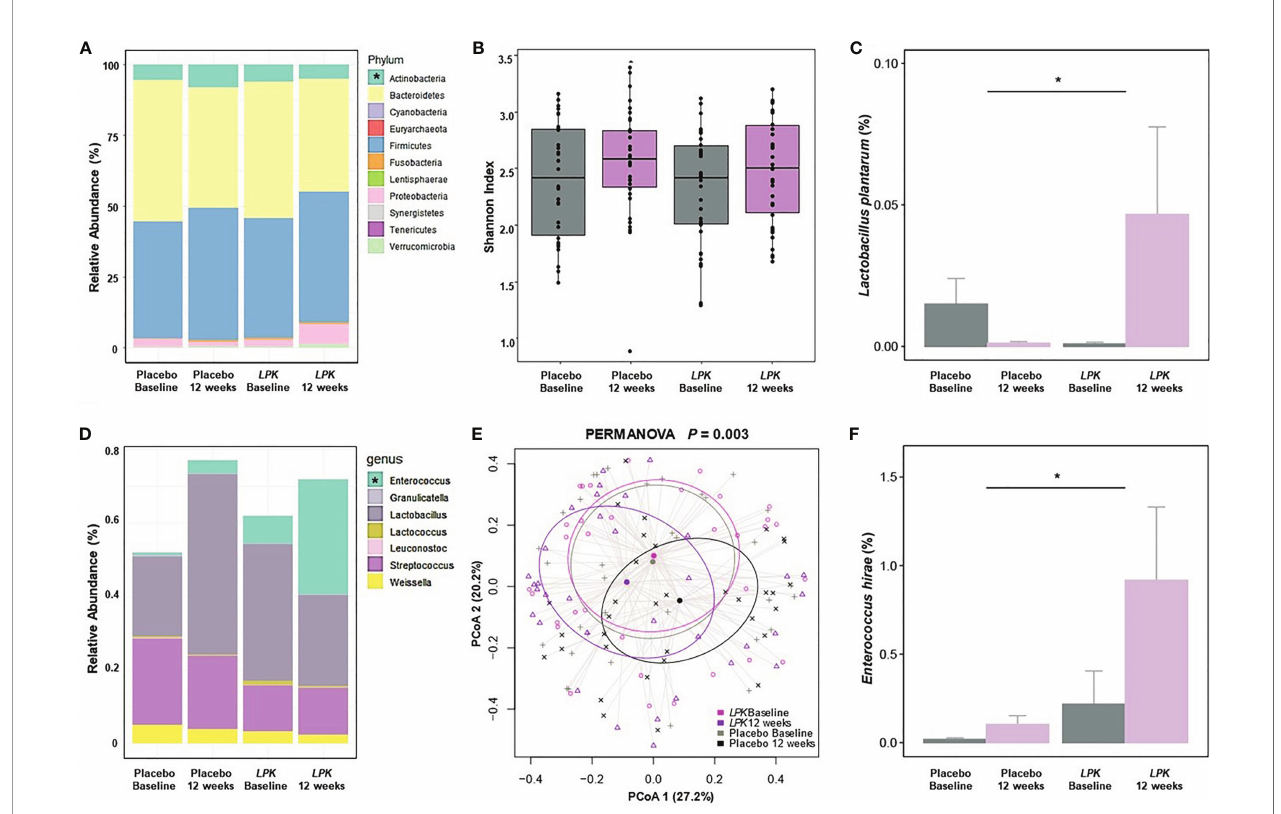
FIGURE 2 | Changes in gut microbiota after a 12-week dietary supplementation with LPK or placebo. (A) Relative abundance of the phyla. (B) The alpha diversity is shown as a Shannon index. (C, F) Comparison of logarithmic mean changes of rare fi ed counts of Lactobacillus plantarum and Enterococcus hirae . (D) Relative abundance of the genera in the order Lactobacillales . (E) The beta diversity as PCoA of the genus in the order Lactobacillales. LPK , Lactobacillus plantarum K50; PCoA, principal coordinates analysis. Asterisks show between-group differences for changes after 12-week supplementation. with a Benjamini – Hochberg adjusted P-value <